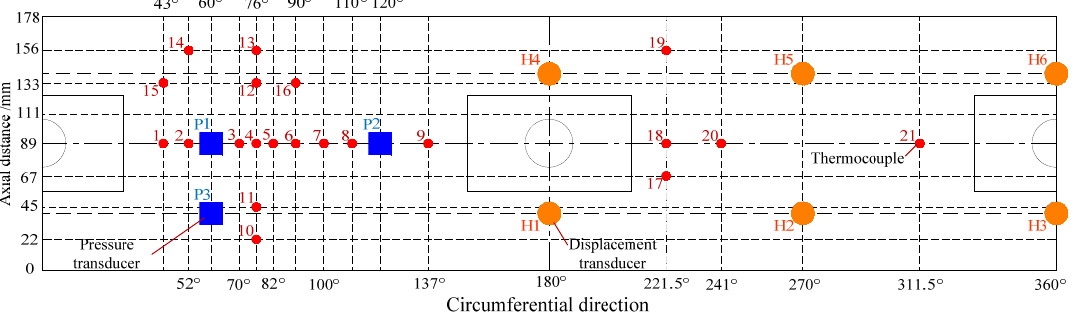
Figure 2. Distribution of different transducers on the test bearing.